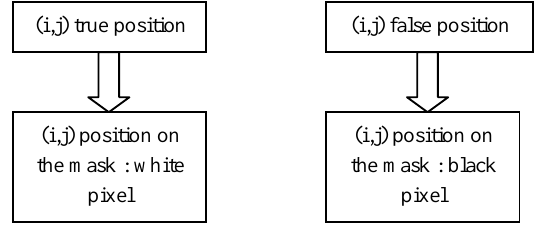
Figure 12: Interpretation of true and false positions for mask’s construction The mask holds a white area corresponding to the detected area.